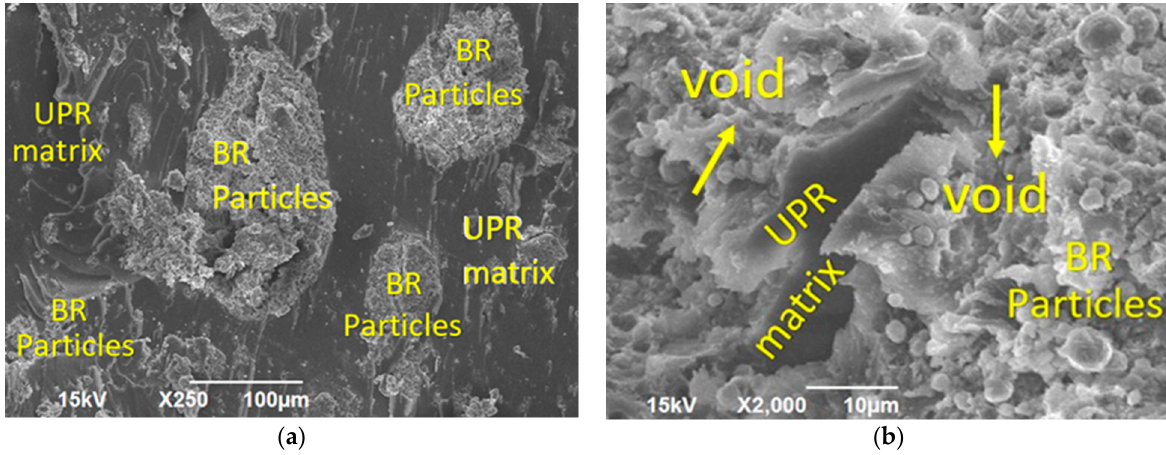
Figure 9. ( a ) SEM images of 20 vol.%; ( b ) 60 vol.% BR-UPR composite.